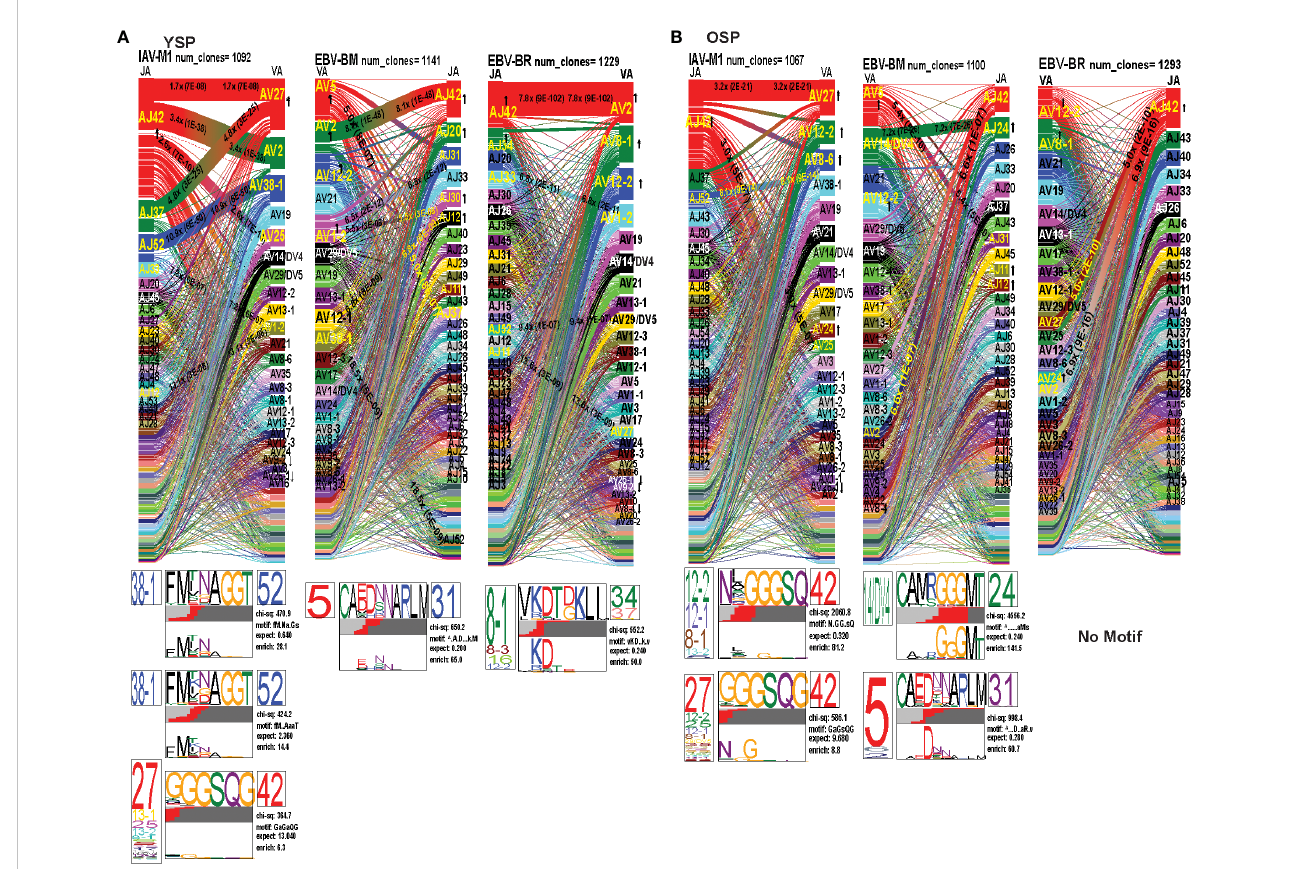
FIGURE 6 The TRAV and TRAJ gene pairing and CDR3 motifs for IAV-M1, EBV-BM and EBV-BR differ between young (Y) and older (O) donors. This was determined after TCR high throughput sequencing of tetramer-sorted CD8 T cells in Y and O donors (Y, n=4; O, n=4-5) using ribbon-plot analyses. Ribbon plots show patterns of TCR V-J pairings in TRAV in young (A, B) older donors (num_clones, indicates the number of clones analyzed). Genes are colored by frequency within the repertoire with red>green>blue>cyan>magenta>black. The arrows indicate signi fi cant fold increase usage of those V or J regions compared to naïve random repertoire suggesting antigen-driven expansion (no. of arrow heads are log 2 ). Underneath each ribbon plot are the unique clearly de fi ned CDR3 motifs of the TRAV repertoire of the indicated antigen-speci fi city. There can be multiple different CDR3 motifs for any one speci fi city. For each CDR3 motif, the upper motif 1 (labeled Mf1 in Y IAV-M1 as a representative) shows the amino acids which are enriched in comparison to the total tetramer+ population of that speci fi city; the lower motif 2 (labeled Mf2 in young IAV-M1 as a representative) shows the amino acids which are enriched compared to a naïve random CD8 T cell repertoire. Both indicate that the identi fi ed amino acids are important for an antigen peptide/MHC contact. Naive repertoires do not generate motifs as this requires the presence of clonal expansions. (analysis method from Dash et al. (6); Kamga et al. (8). The text within the bars joining particular AV and AJ regions indicate the fold increased usage of that pairing (and statistical signi fi cance) compared to a naïve random TCR repertoire. Bar in between the Mf1 and Mf2 depicts which part of the CDR3 is derived from the V (light grey), N (red), D (black) and J (dark gray)